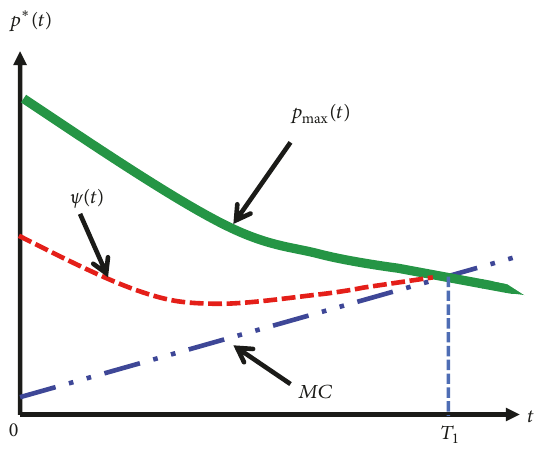
Figure 3: The optimal dynamic price